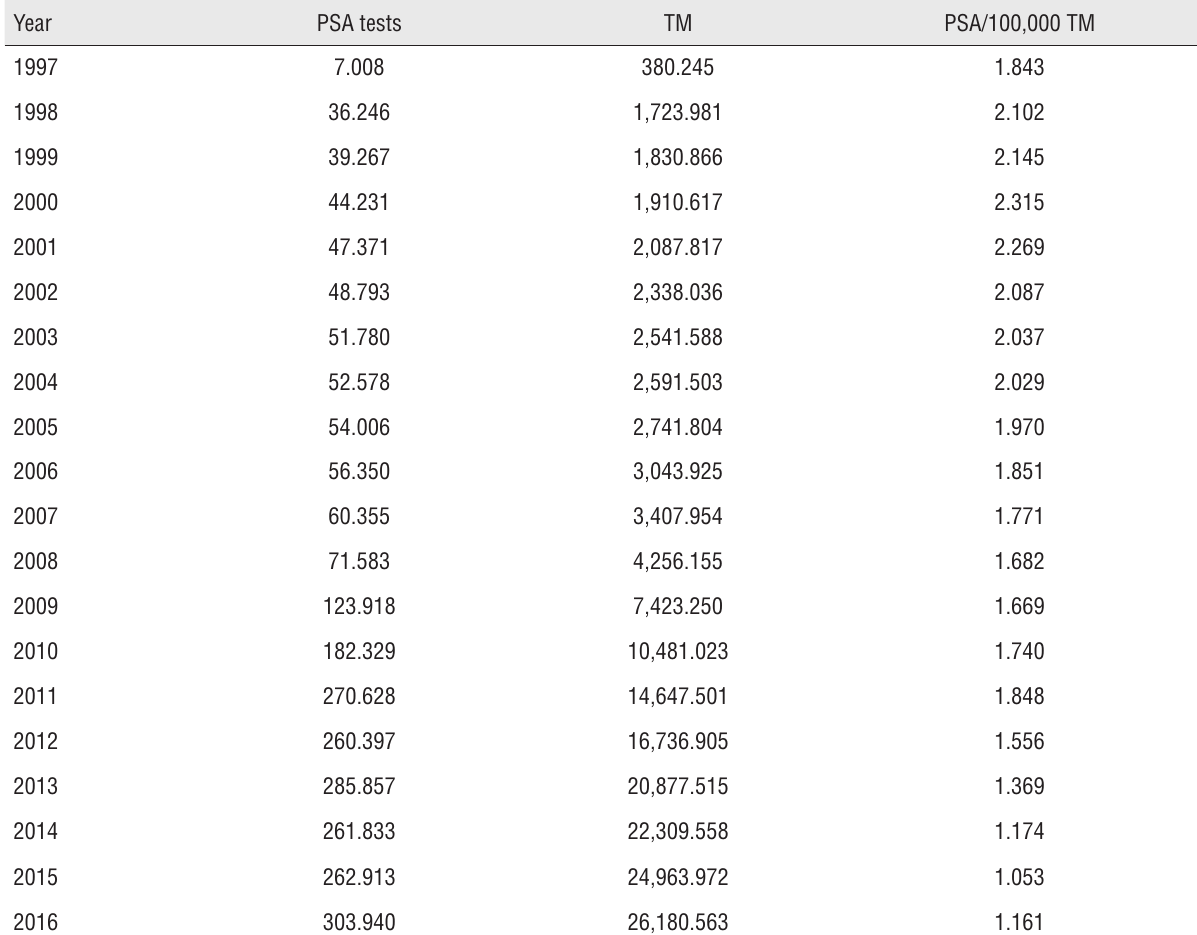
Table 1 - Number of total and relative PSA tests per year.